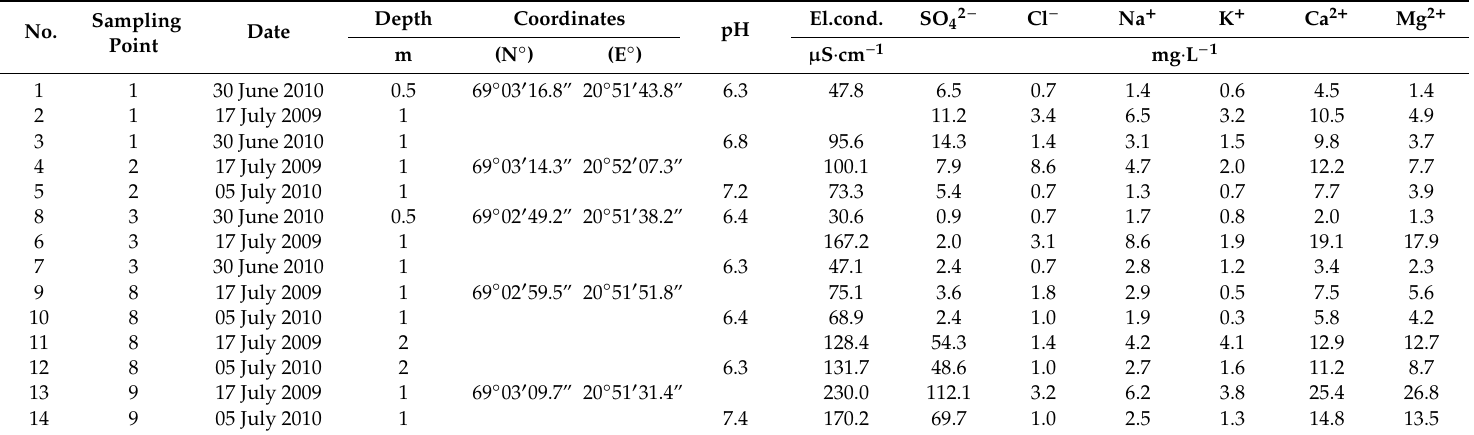
Table 2. Chemical composition of subsurface water in the Lake Saana catchment in 2009 and 2010.